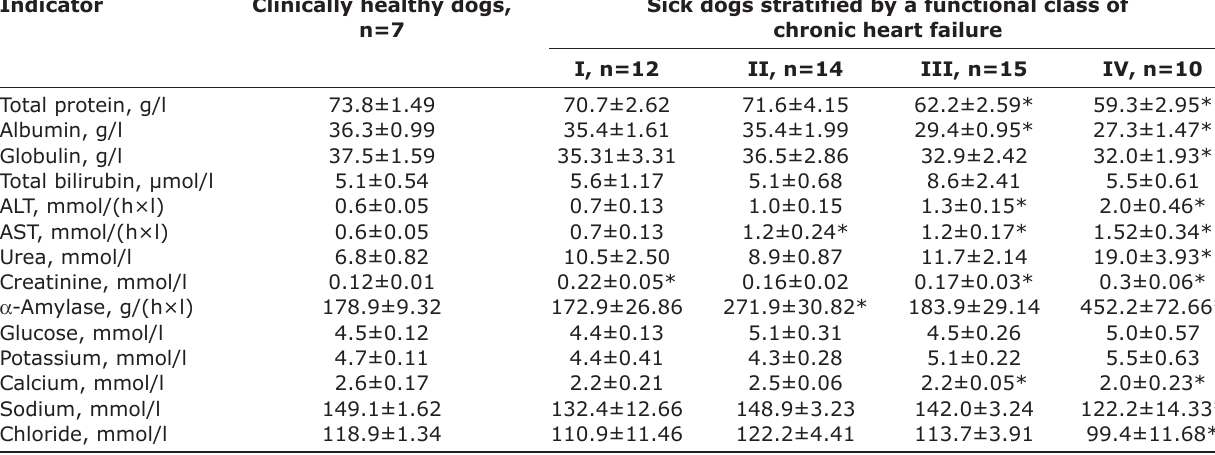
Table-3: Biochemical parameters of dogs with dilated cardiomyopathy according to their functional class of heart failure, M±m, n=10-15.